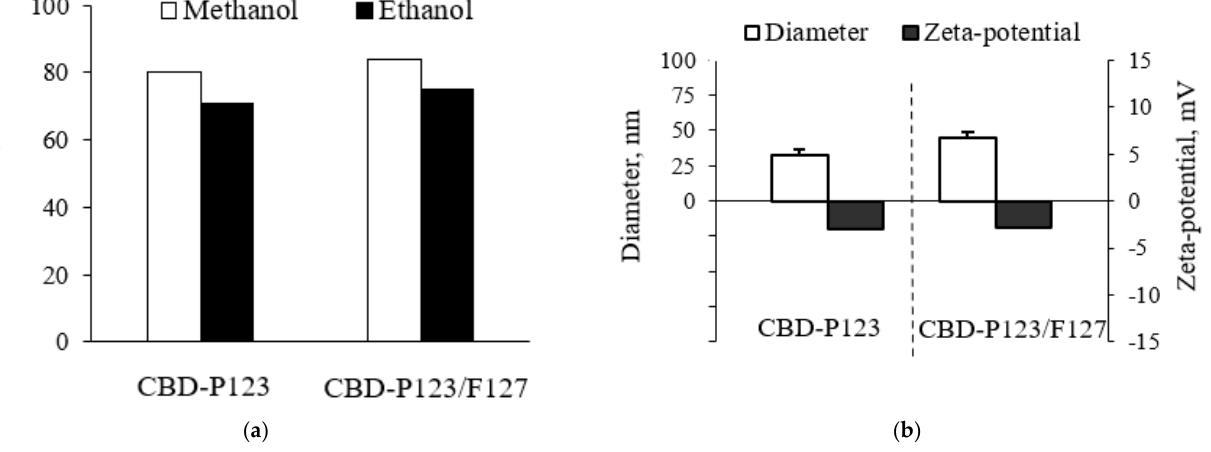
Figure 1. Encapsulation efficiency depending on the applied solvent ( a ) and physicochemical characteristics ( b ) of cannabidiol-loaded Pluronic P123 and mixed P123/F127 micelles.